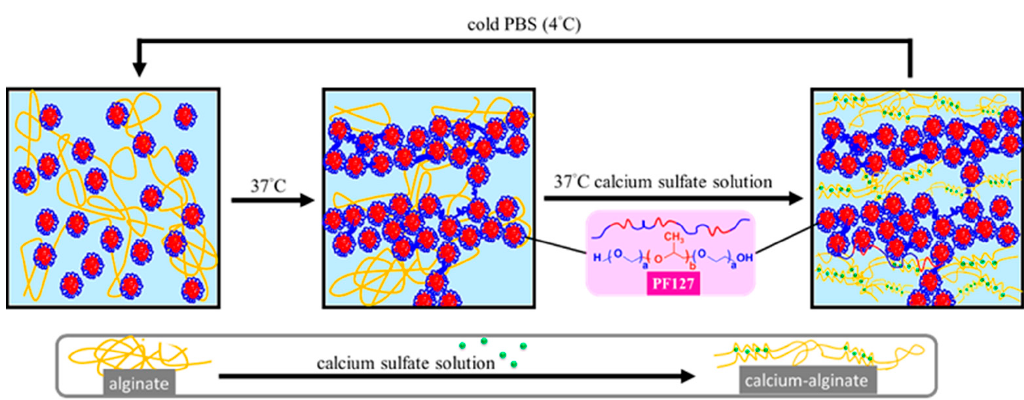
Scheme 1. A novel reversible interpenetrating polymeric network hydrogel is made up of a thermosensitive network and calcium-ion-crosslinked alginate. thermosensitive network and calcium-ion-crosslinked alginate.